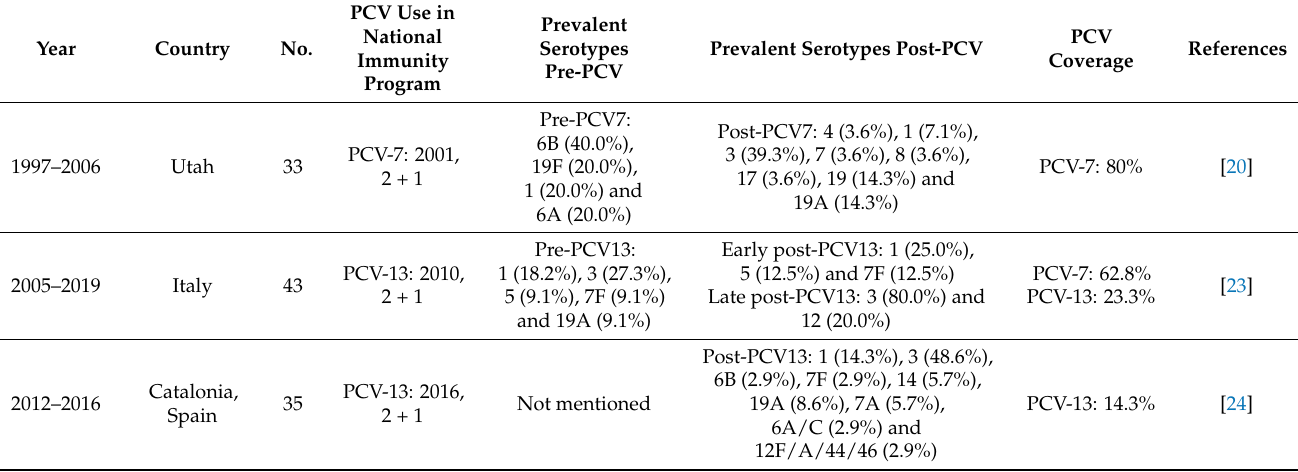
Table 1. Prevalent serotypes of Streptococcus pneumoniae in